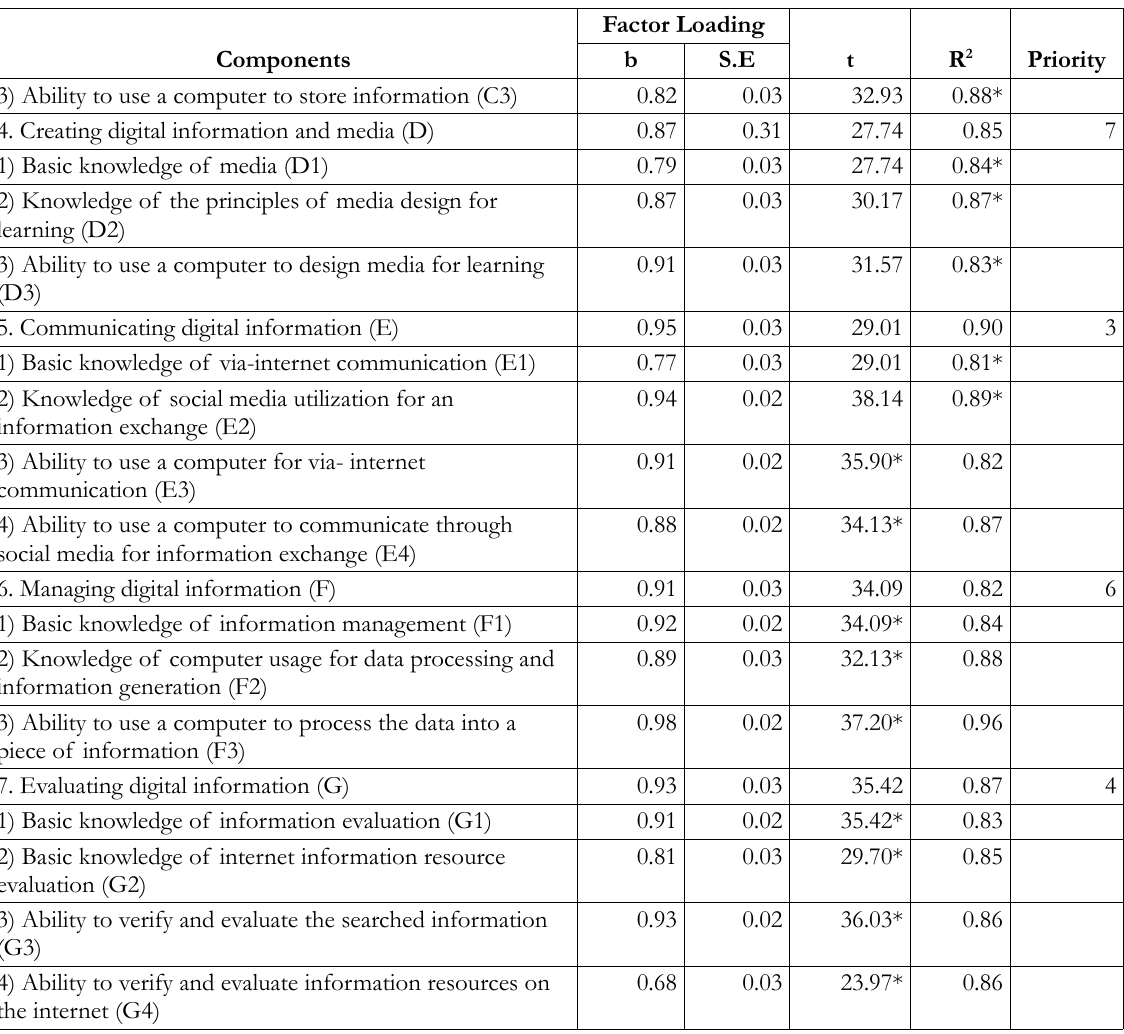
Table 4. Factor Loadings, covariances, and priority values of the essential digital competency components. Table 4 exhibits the priority of the components from high to low and Priority 1 was “Accessing digital information (B).” The variables ranked from “Ability to employ information search tools using technology (B3)”, “Knowledge of information access (B1)”, to “Knowledge of information search strategies